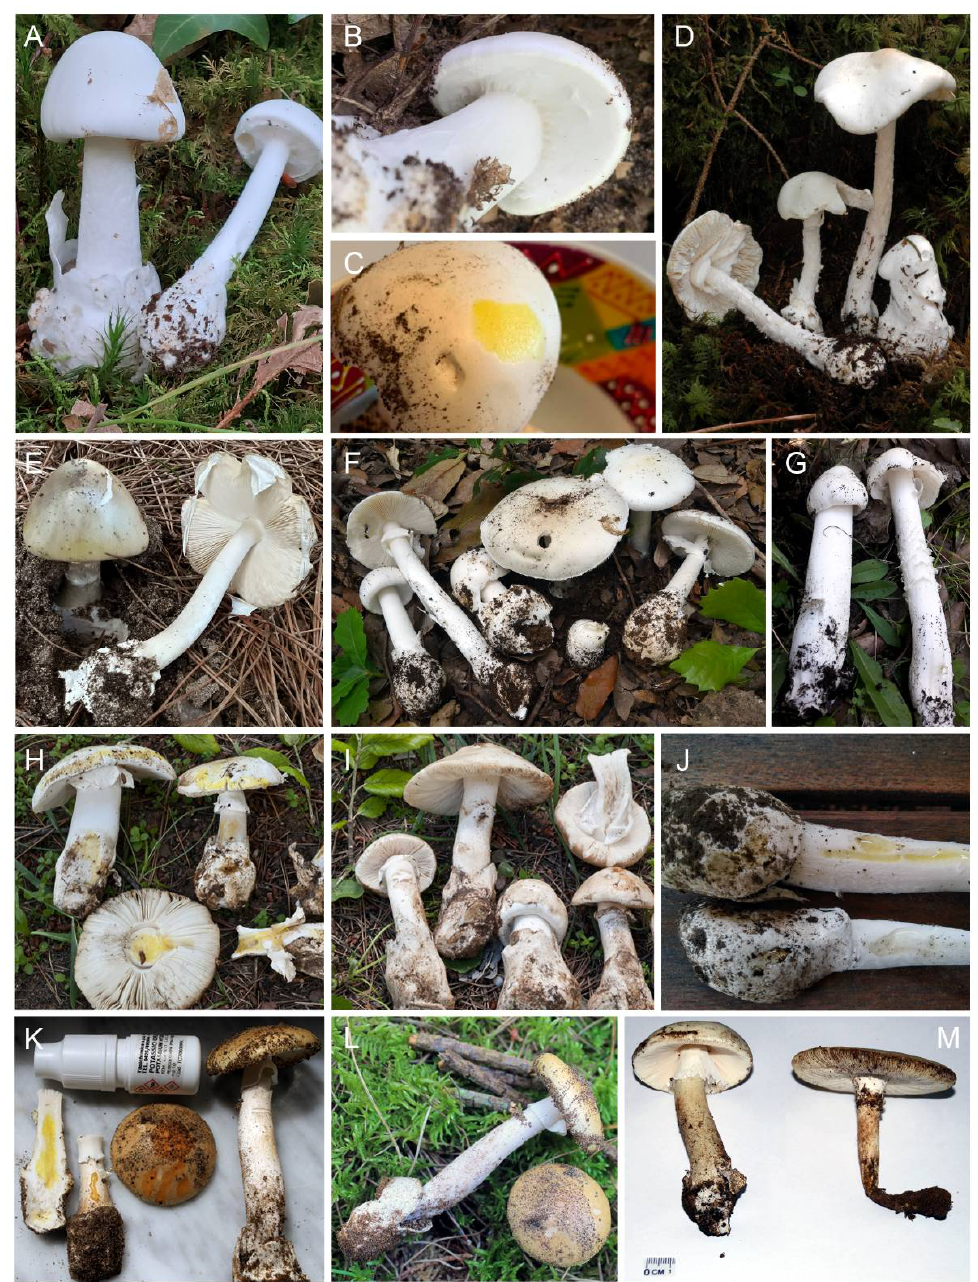
Figure 2. Macroscopical features of ‘destroying angels’ ( A , B ). Amanita amerivirosa . (LIP:0402252), photo P.-A. Moreau. ( C ) Amanita amerivirosa , reaction to 10% KOH (LIP:0402250), photo N. Journe. ( D ) Amanita virosa , neotype (LIP:0402243), photo P.-A. Moreau. ( E ) Amanita phalloides (LIP:0401670). ( F ) Mixed basidiomes of Amanita verna (LIP:0402254) and A. vidua (LIP:0402256), photo M. Gelardi. ( G ) Amanita phalloides f. porrinensis (LIP:0402258), photo A. Mua. ( H ) Amanita verna (AH:31849), photo G. Moreno. ( I ) Amanita vidua (AH:19696), photo G. Moreno. ( J ) Amanita verna (LIP:0402254, top) and A. vidua (LIP:0402256, bottom) reaction to KOH, photo M. Gelardi. ( K , L ) A. verna ‘f. xanthoviridis ’ ad. int. (LIP:0002275), photo M. Raumi. ( M ) Amanita vidua from Lebanon (1C and 1P). Invalid names = Hypophyllum virosum Paulet Trait é champ. Comest. (Paris): 2: 326 (1793) [inval., op. rejic.]